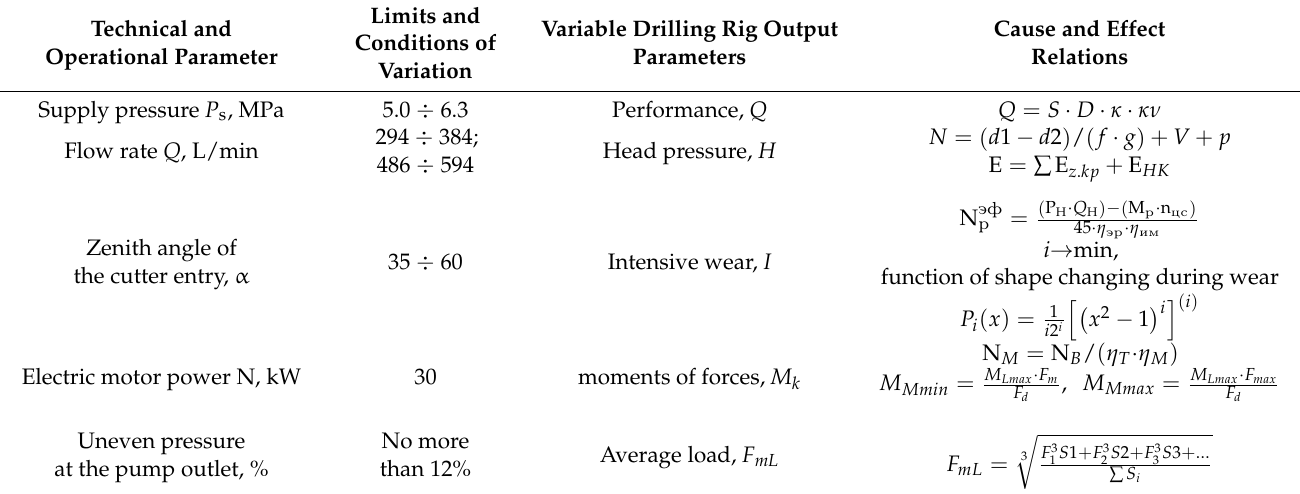
Table 1. Factors influencing the determination of cause and effect relationships when justifying performance criteria. Technical and Operational